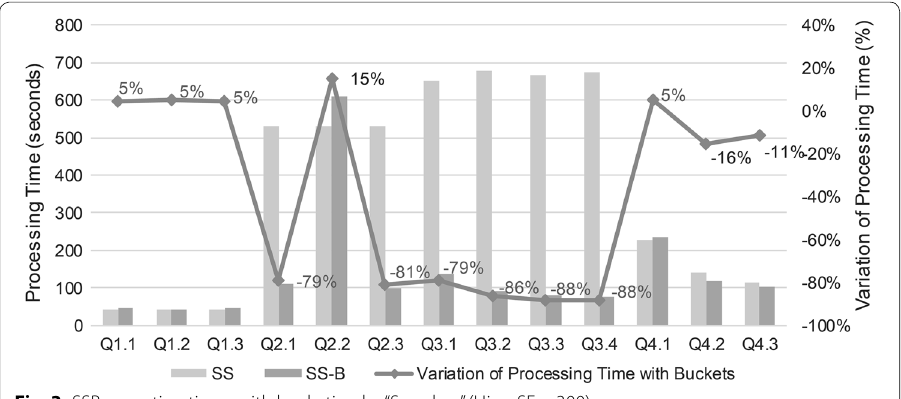
Fig. 3 SSB execution times with bucketing by “Suppkey” (Hive, SF